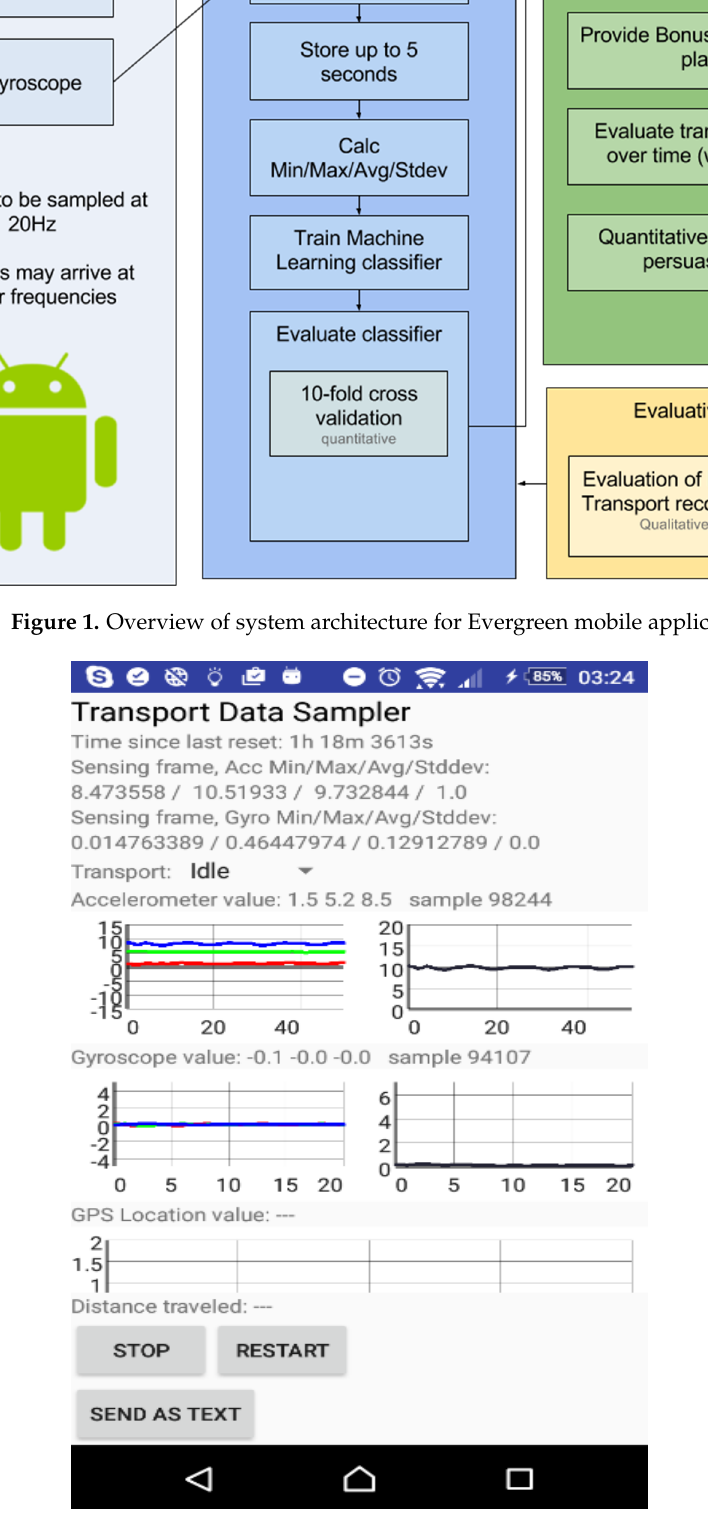
Figure 2. Transport Data Sampler application for the submission of transport sample data.